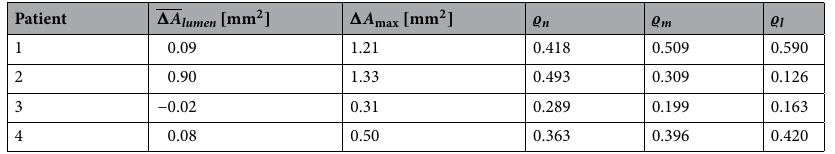
Table 1. Correlation coefficient between observed change in lumen area from baseline to follow-up exam and computed rate of leukocyte adhesion. The correlation coefficient is provided for different species of leukocytes: n = neutrophils; m = monocytes; and l = lymphocytes. The table also shows the average (along the centerline) and maximum change of lumen area observed from clinical data, (cid:31) A lumen and (cid:31) A max , respectively.